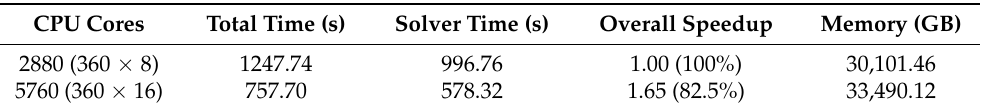
Table 14. Summary of Example 7.